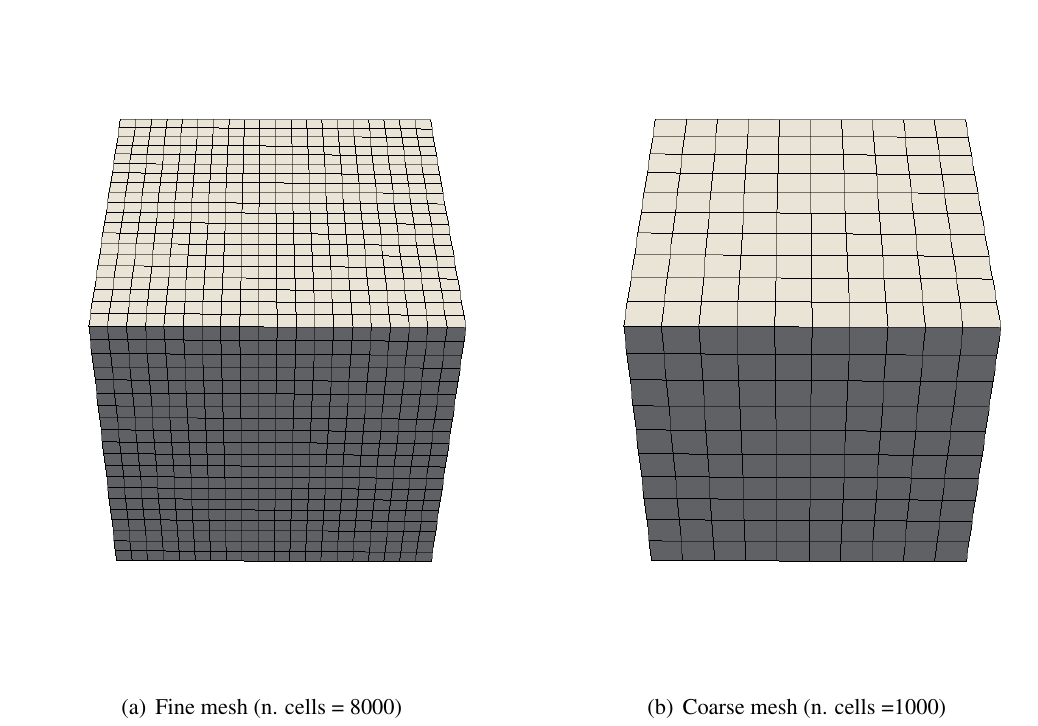
Fig. 1 Meshes for 3D cuboid